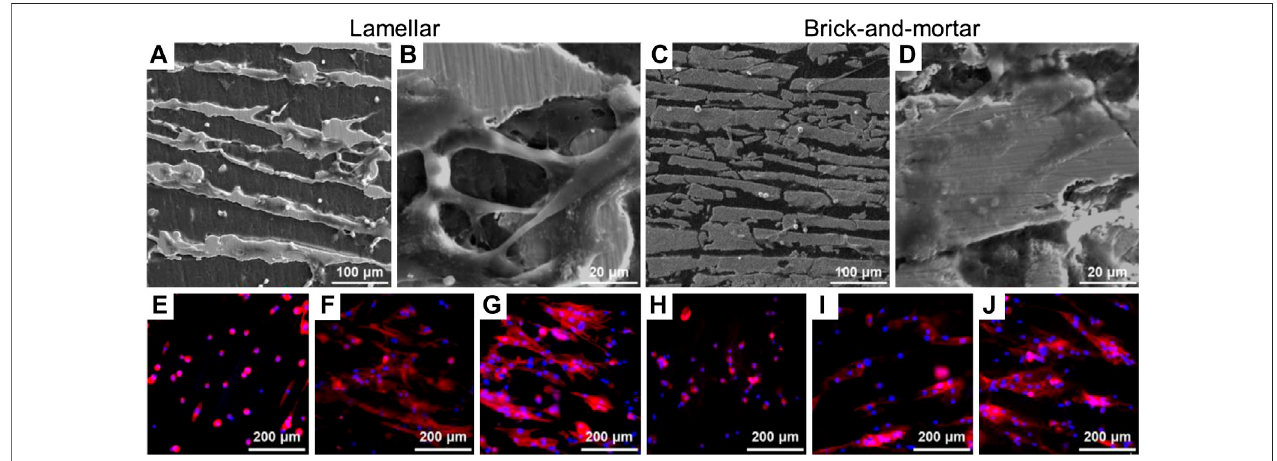
FIGURE 3 | Adhesion of HPDLF cells on different samples. (A – D) Scanning electron microscopy morphologies of co-culture (A,B) Lamellar for 24 h, (C,D) Brick- and-mortarfor24 h (E – J) Cytoskeleton stainingoftheexperimental samplesofco-culture,whichDAPIfornuclei(blue)andrhodamine-phalloidinforF-actinstress fi bers (red) double stain: (E) Lamellar for 6 h, (F) Lamellar for 24 h, (G) Lamellar for 72 h, (H) Brick-and-mortar for 6 h, (I) Brick-and-mortar for 24 h, (J) Brick-and-mortar for 72 h.